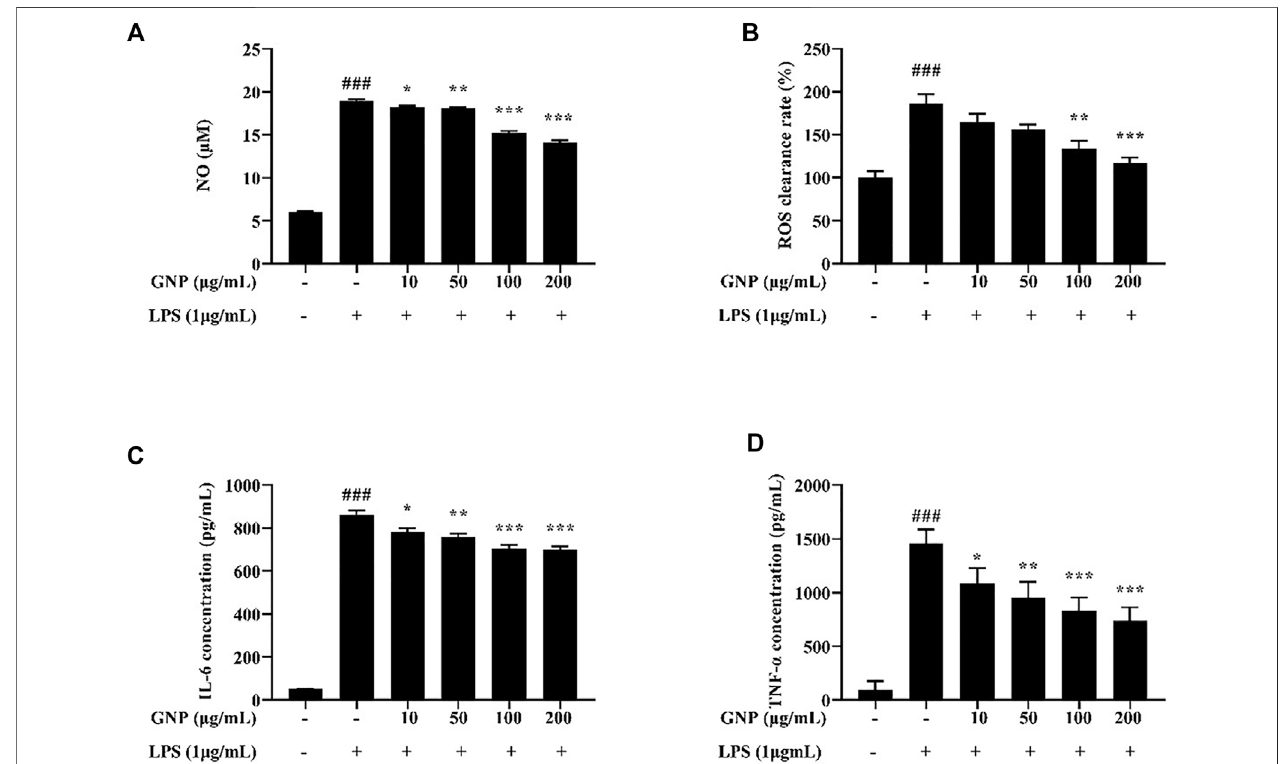
FIGURE5|(A) EffectofGNPonNOlevelsinLPS-inducedRAW264.7cells. (B) EffectofGNPonROSlevelsinLPS-inducedRAW264.7cells. (C) EffectofGNPon TNF- α levels in LPS-induced RAW 264.7 cells. (D) Effect of GNP on IL-6 levels in LPS-induced RAW 264.7 cells. Data are expressed as mean ± SD (n (cid:1) 3). (# indicates thesigni fi cantdifferencebetweentheLPSgroupandtheblankgroup,# p < 0.05,## p < 0.01,### p < 0.001;*indicatesasigni fi cantdifferencebetweentheexperimental group and the LPS group, * p < 0.05, ** p < 0.01, *** p < 0.001).